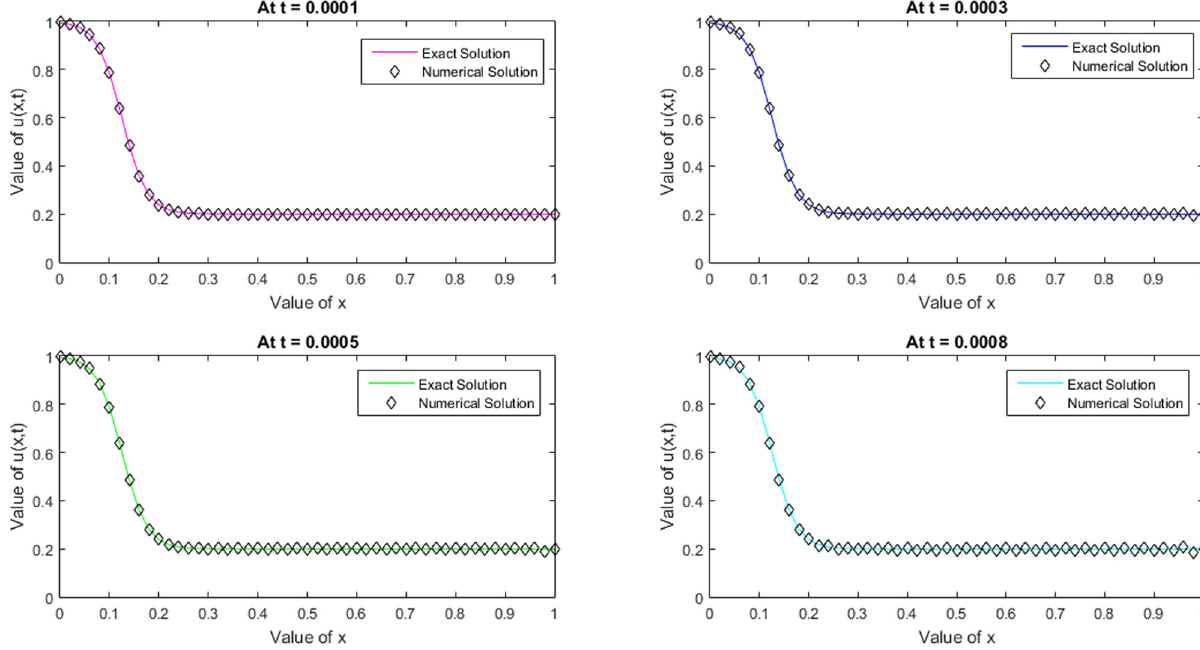
Figure 7: Plot for solutions for = N 101 , = t